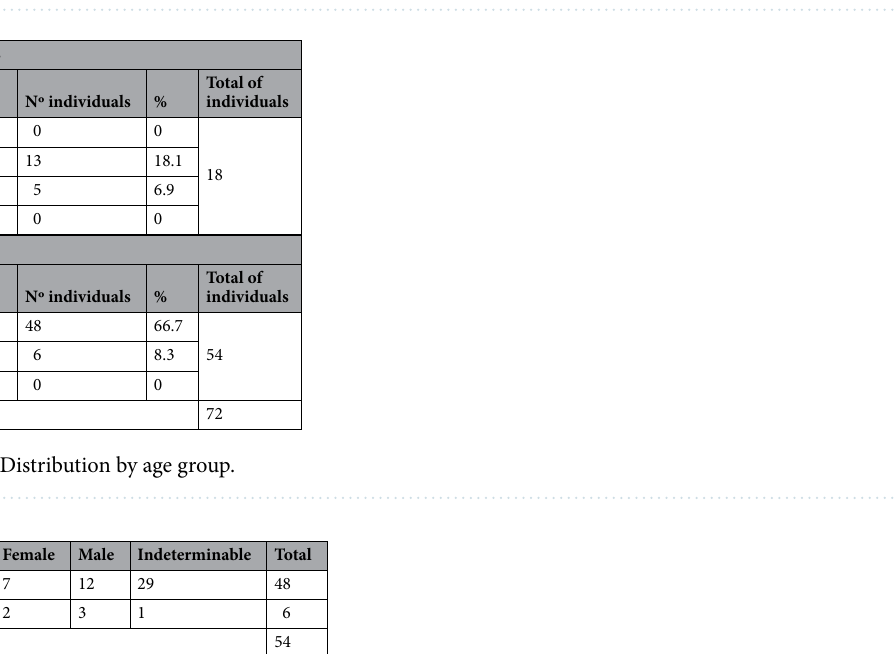
Figure 5. Synchronous contexts and patterns at Campo de Hockey, as defined by the Chi-square test of radiocarbon dates. Note: the letter C used in the column ‘Structure and individual’ in 14 C corresponds to T in this paper (this is due to the Spanish–English translation of ‘trench’).